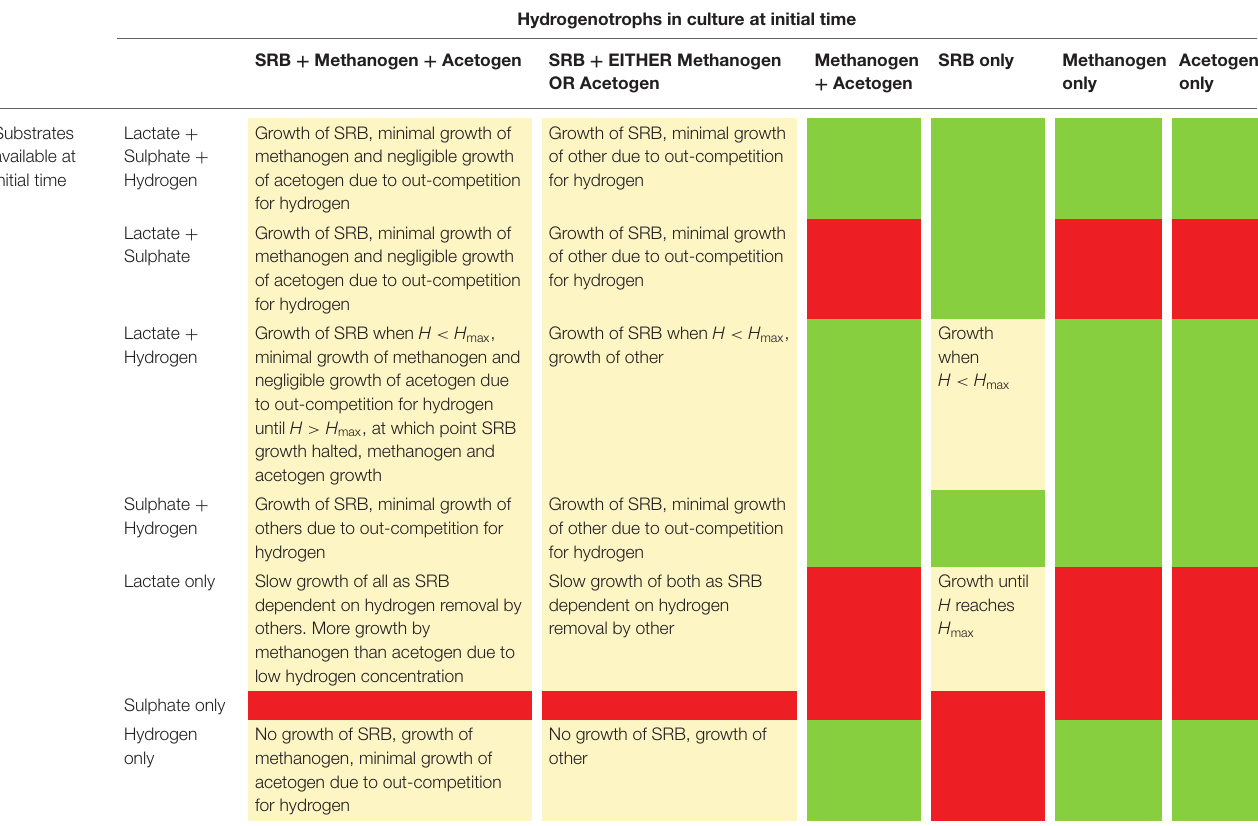
TABLE 2 | Outcomes of batch culture under various initial